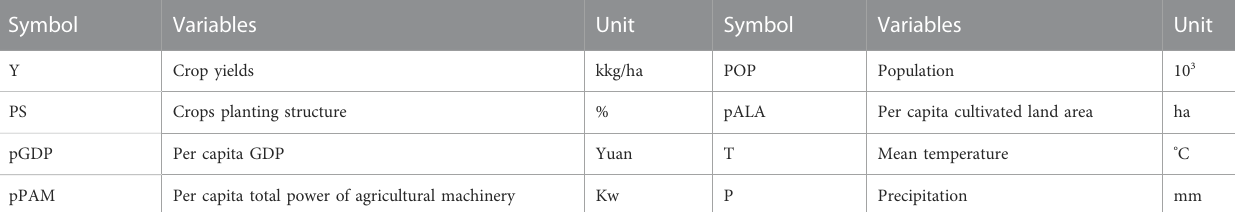
TABLE 2 Dependent and independent variables used in this study.